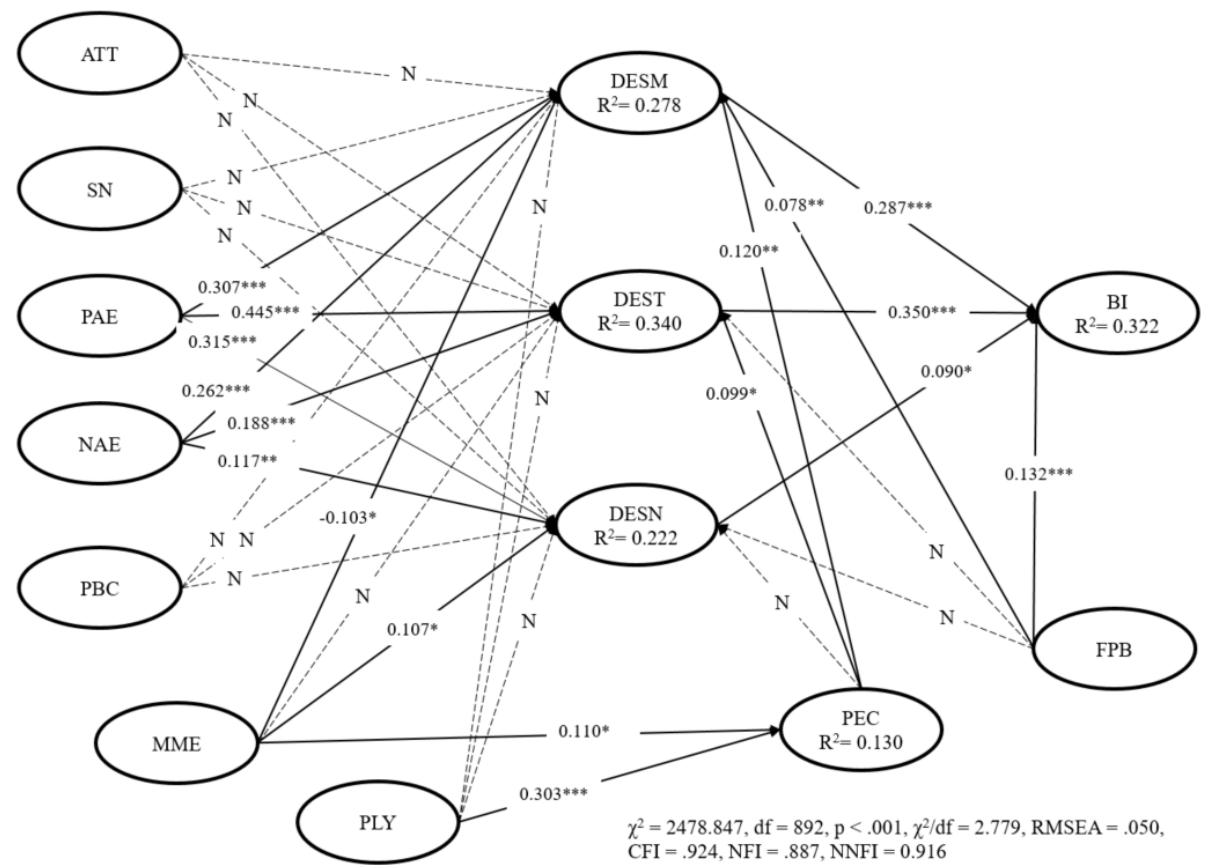
Figure 2. Results of the structural model. Notes: * p < 0.05, ** p < 0.01, *** p < 0.001. Table 5. Standardized parameter estimates of structural model (N = 711). also found to be positive and significant ( β MME → PEC = 0.112, t = 2.290, p < 0.05; β PLY → PEC = 0.303, t = 6.711, p < 0.001), supporting H6d, H7d, H8d. In addition,